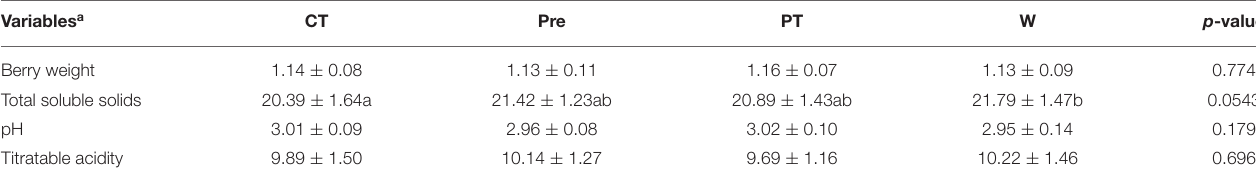
TABLE 1 | Effects of the four mini-greenhouse treatments (CT, control; Pre, pre-veraison; PT, post-veraison; W, whole season) on berry weight (g), total soluble solids ( ◦ Brix), pH, and titratable acidity (g L − 1 of tartaric acid eq) of L’Acadie blanc berries, vintage 2020.